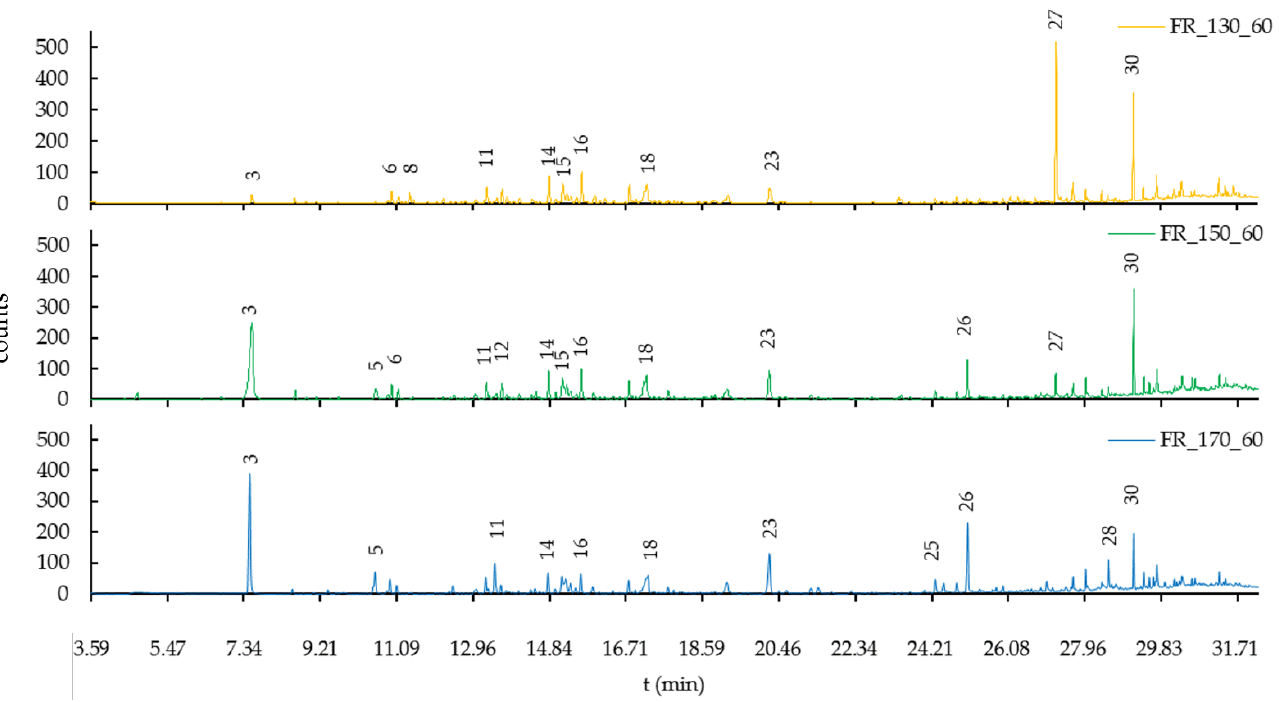
Figure 6. GC-MS diagram of the forest residue (FR) hydrothermally treated at 130, 150 and 170 °C with a 60 min holding time, see peak numbers in Table 6.